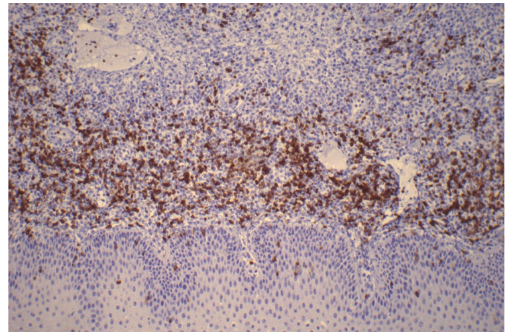
Figure 5: Immunohistochemical marker staining.